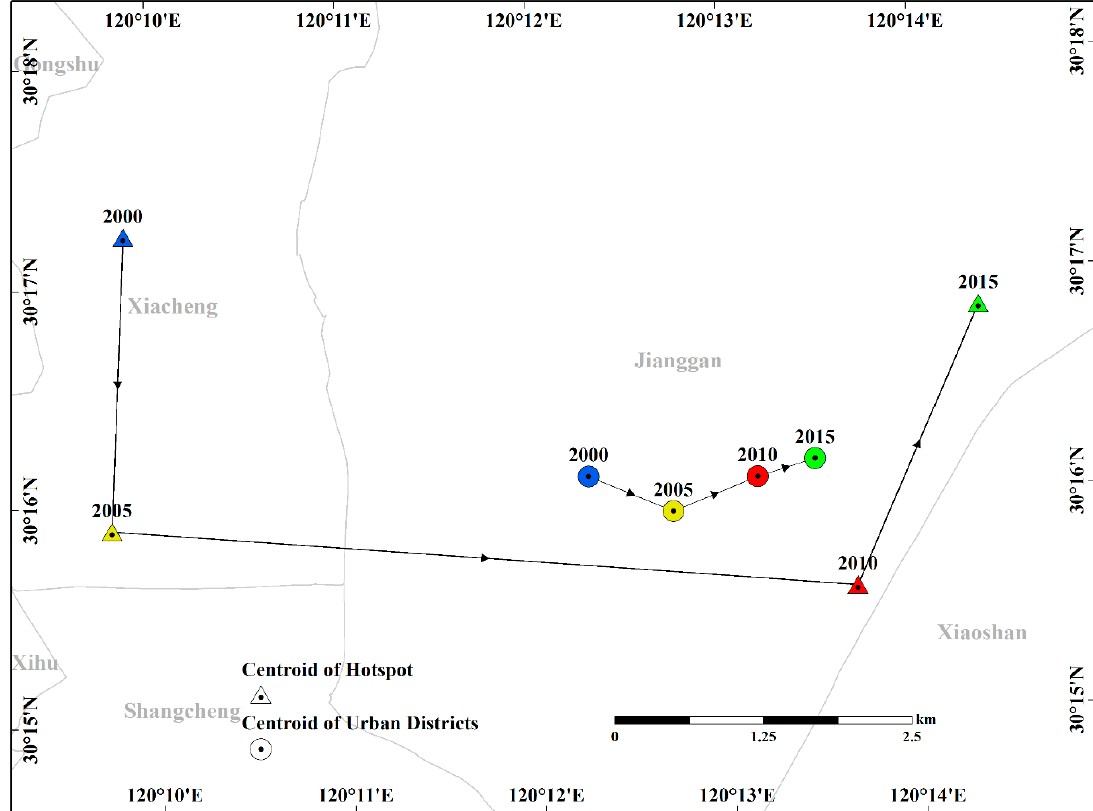
Figure 6. Centroid trajectories of hot and very hot spot areas and the urban area in HMA during 2000 –